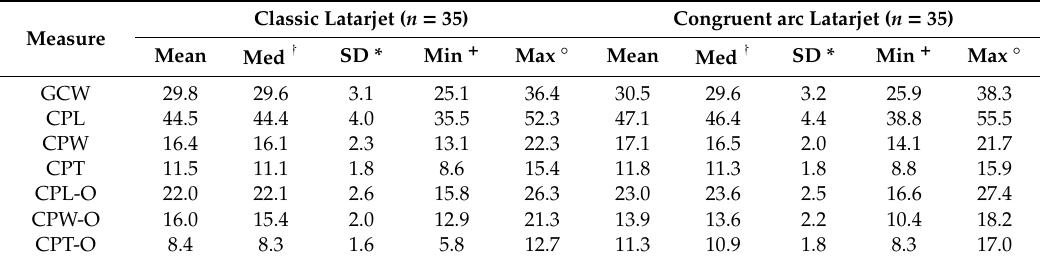
Table 2. Dimensions of glenoid cavity and coracoid process prior and post graft preparation in mm ( n = 70).